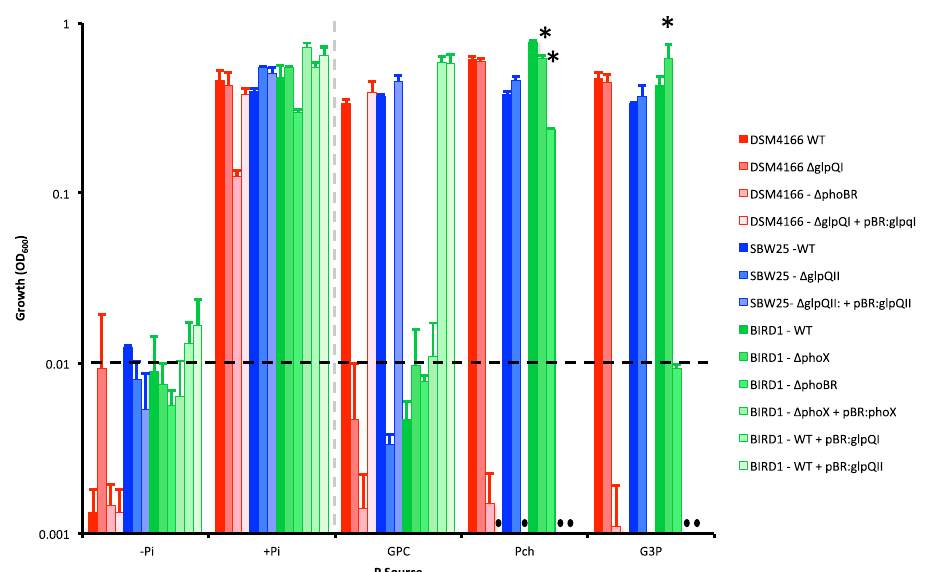
Figure 2. Growth of three Pseudomonas strains on differing organic phosphorus (P) compounds as a sole P source (100 μ M) using succinate (20 mM) as the carbon source. Results shown are the mean of triplicate cultures. The dashed black line indicates approximate OD 600 at T = 0. The dashed grey line segregates the positive and negative controls to the organic P treatments. Asterisks denote a significant (T-test, P < 0.05) reduction in growth rate (Fig. S5). Error bars denote standard deviation. Abbreviations: − P, no added orthophosphate; + P 100 µ M orthophosphate added; Pch, phophorylcholine; G3P, sn -glycerol-3-phosphate; GPC, glycerolphosphorylcholine; DSM4166, P . stutzeri DSM4166; SBW25, P . fluorescens SBW25; BIRD-1, P . putida BIRD-1; WT, wild type; Δ glpQ , mutant genotype for the secreted glycerolphosphodiesterase; Δ phoBR , mutant genotype for the master regulator of the phosphate starvation response network; Δ phoX , mutant genotype for alkaline